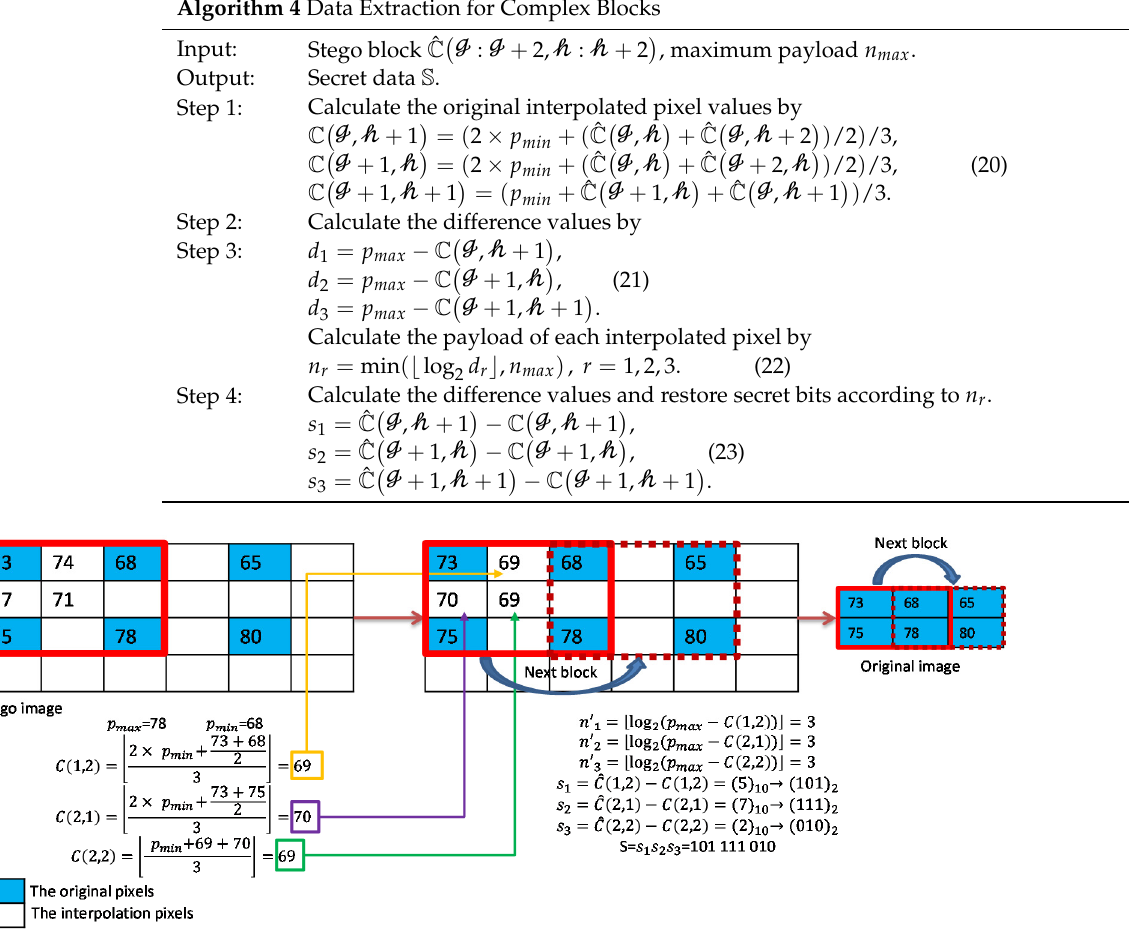
Algorithm 4 Data Extraction for Complex Blocks